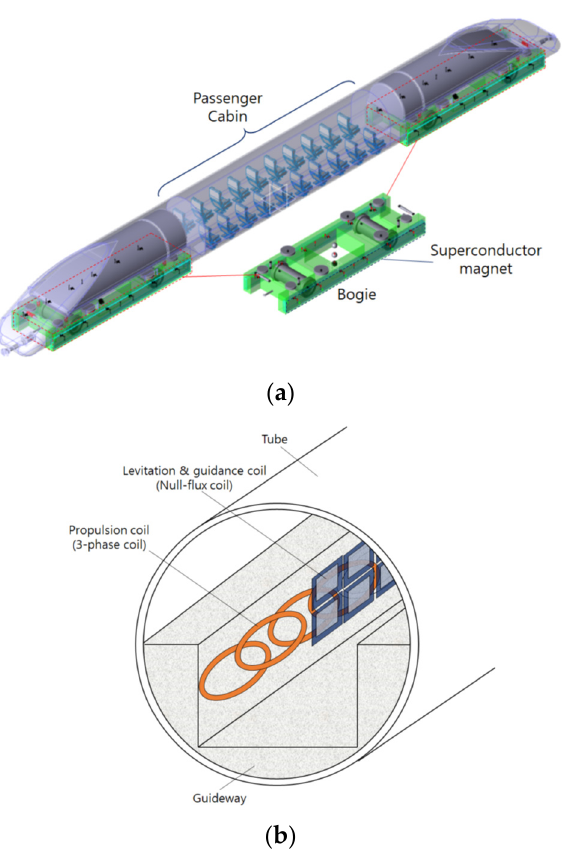
Figure 1. Conceptual diagram of the Hyperloop system: ( a ) vehicle, ( b ) tube